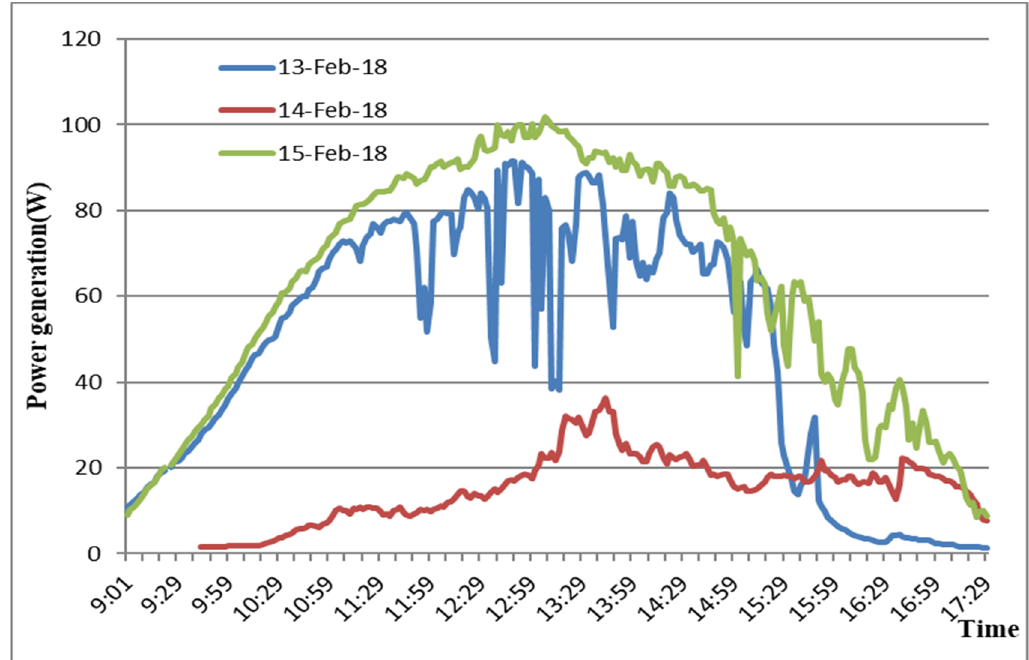
Figure 6. Power generation of PV windows.